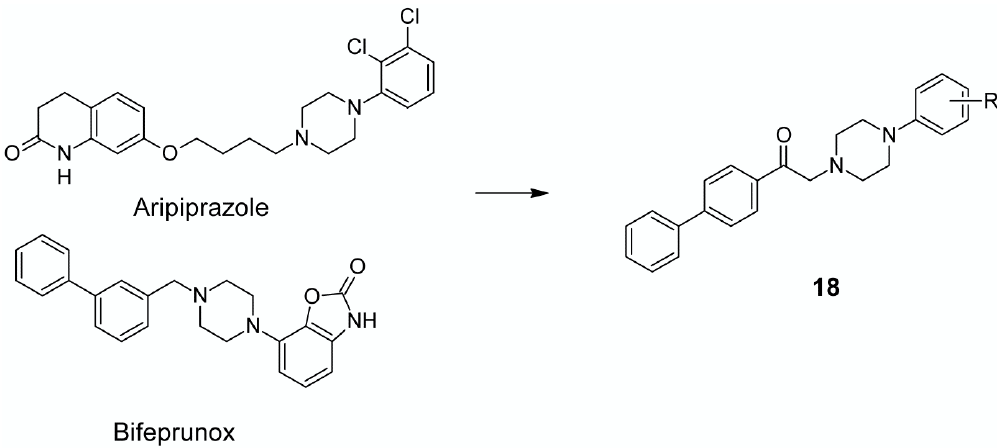
Figure 9. Design of multi-target hybrid compound based on aripiprazole and bifeprunox scaffold.